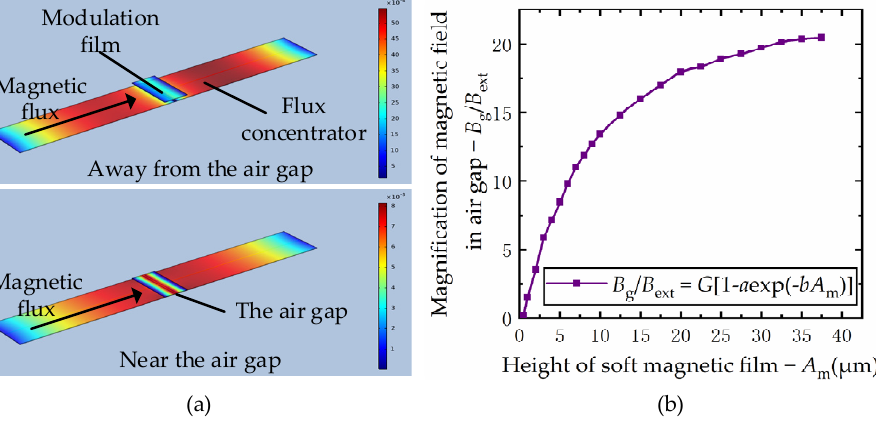
Figure 3. Finite element simulation of the relationship between the modulated signal B g and the height of the modulation film A m : ( a ) simulation model of flux modulation structure; ( b ) simulation results of the relationship between magnetic field in air gap and the height of modulation film.